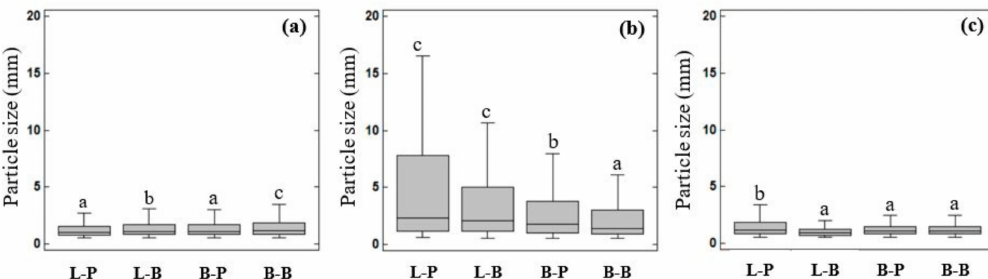
Figure 3. Bolus particle size obtained after the oral ( a ), gastric ( b ) and intestinal ( c ) phase of in vitro digestion. Sample names describe bread type (L-loaf, B-roll bread) followed by letters describing